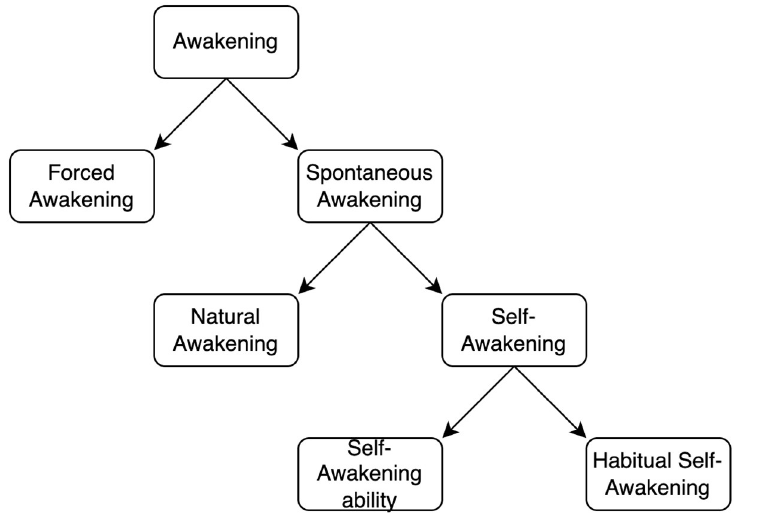
Fig 1. Schematic representation of a taxonomy for